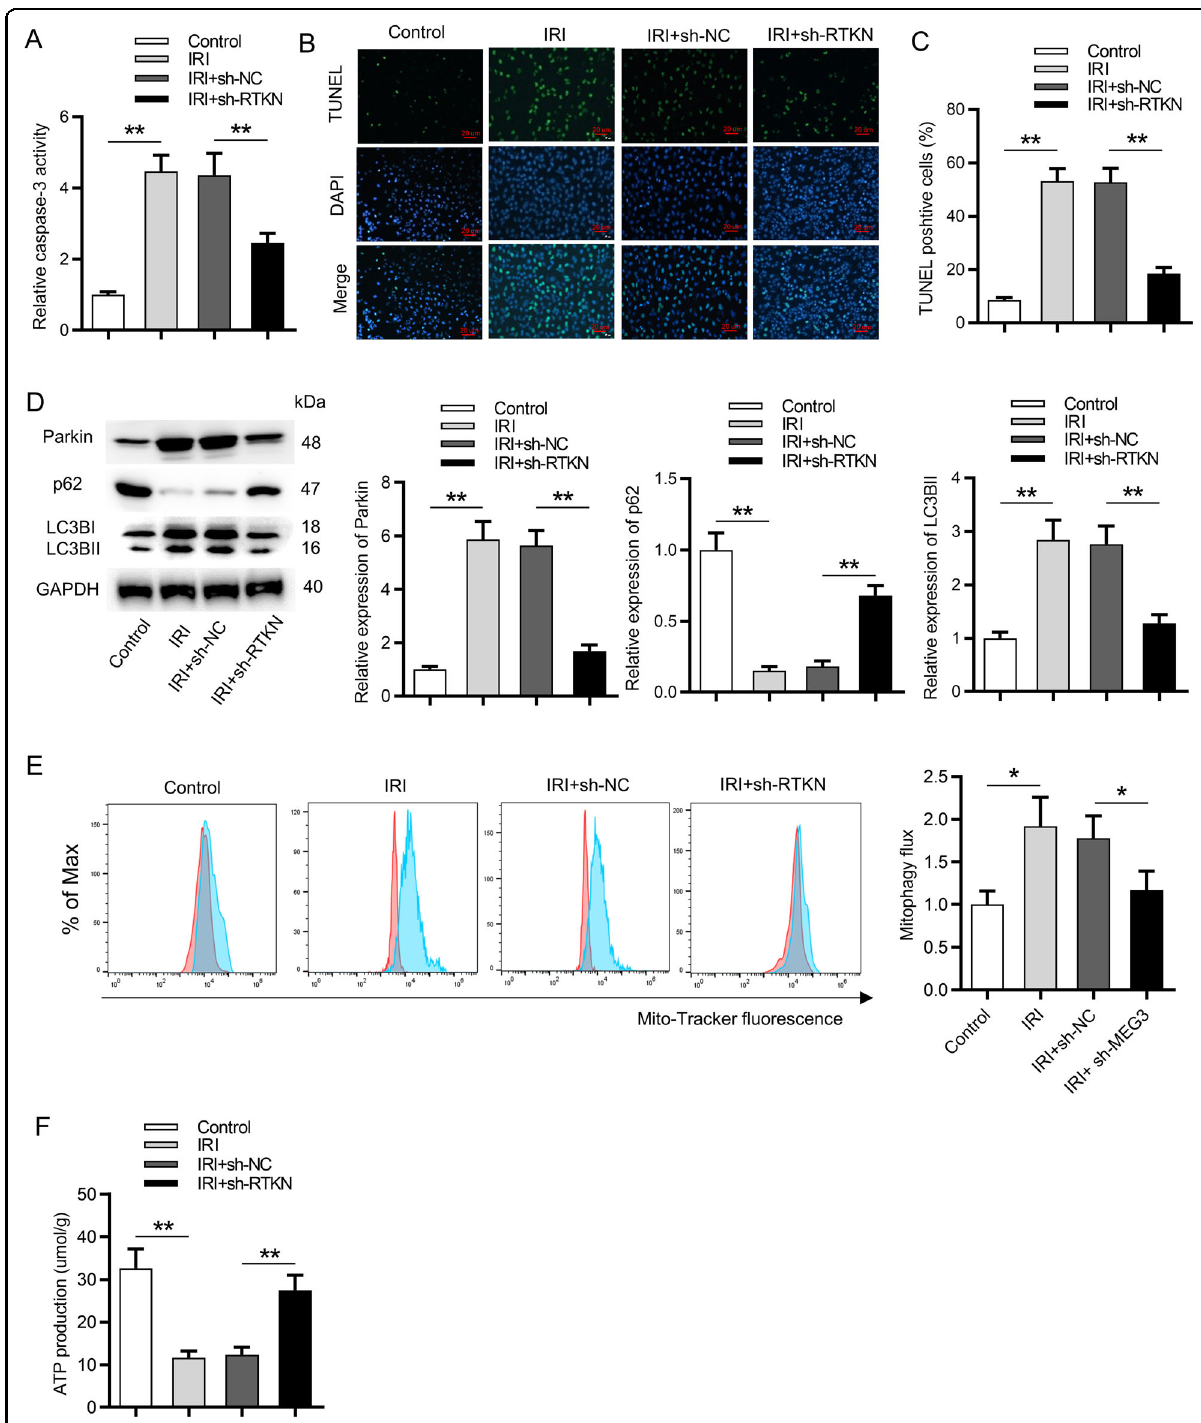
Fig. 6 Inhibition of RTKN reduced cell apoptosis and mitophagy in HK-2 cells followed by IRI. A The in fl uence of silenced RTKN on caspase-3 activity was determined via a caspase-3 activity kit. B , C A TUNEL assay detected the number of TUNEL-positive cells in IR-treated HK-2 cells transfected with sh-RTKN. D Western blot analysis showed the protein levels of Parkin, p62, LC3B-I, and LC3B-II in IRI-treated HK-2 cells transfected with sh-RTKN. E MitoTracker Green FM staining revealed the in fl uence of silenced RTKN on mitophagy fl ux. Red color indicated DMSO and blue color indicated Baf. F In fl uence of silenced RTKN on ATP production in IR-treated HK-2 cells was measured. * p < 0.05, ** p <